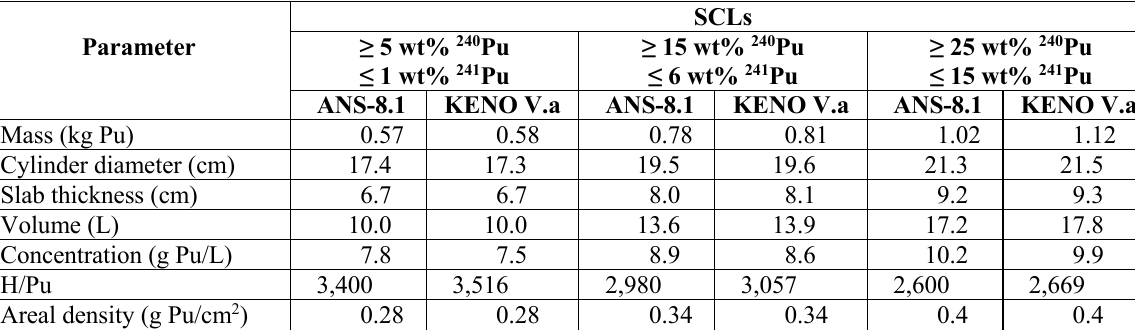
) containing 240 3 4